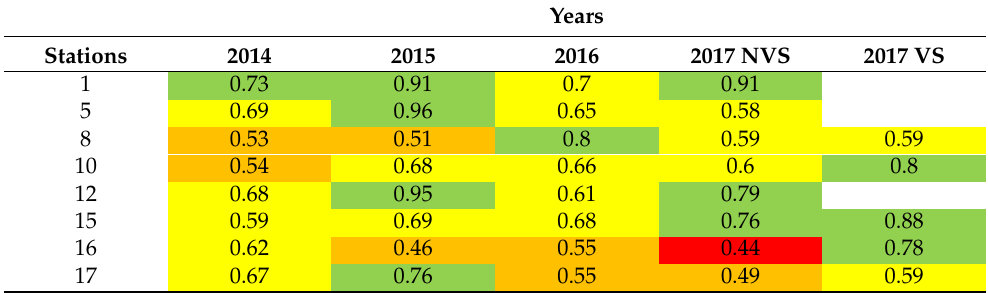
Table 1. M-AMBI results from 2014 ante transplant operations to 2017 post-transplant